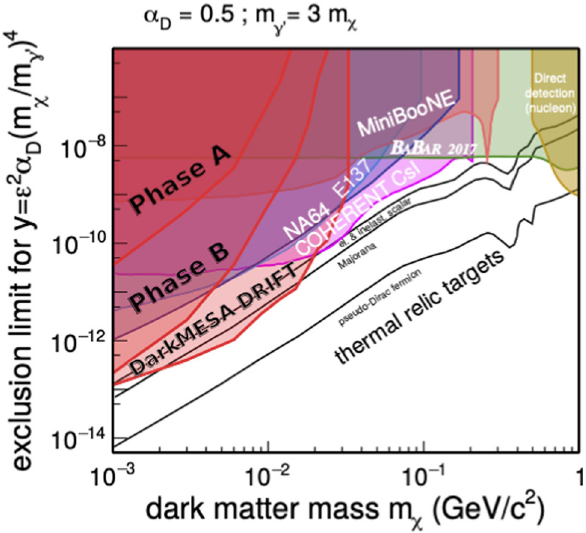
Fig. 47 DarkMESA projected exclusion limits for the y parameter as a function of the DM particle mass for the invisible dark photon decay γ (cid:4) → χ ¯ χ compared to existing limits